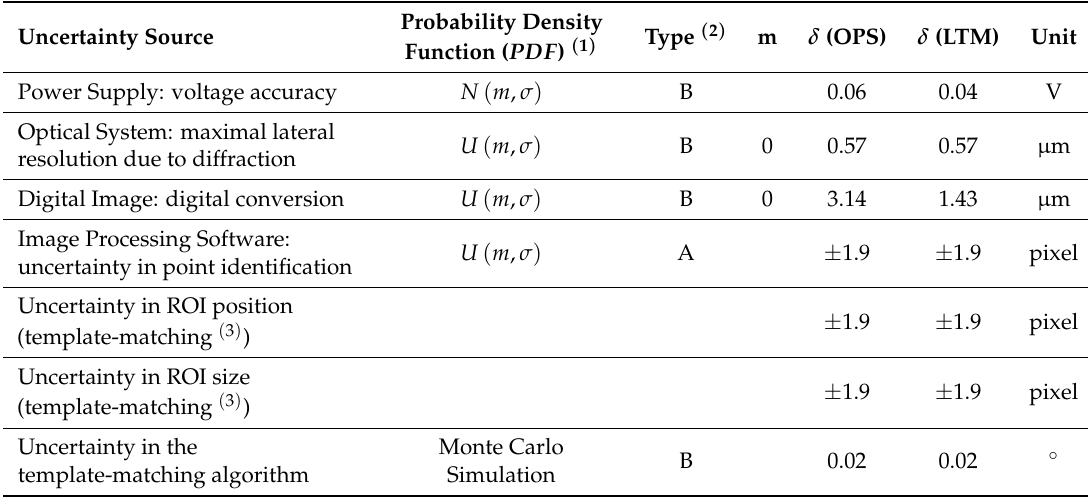
Table 3. OPS and LTM measurement setup uncertainty